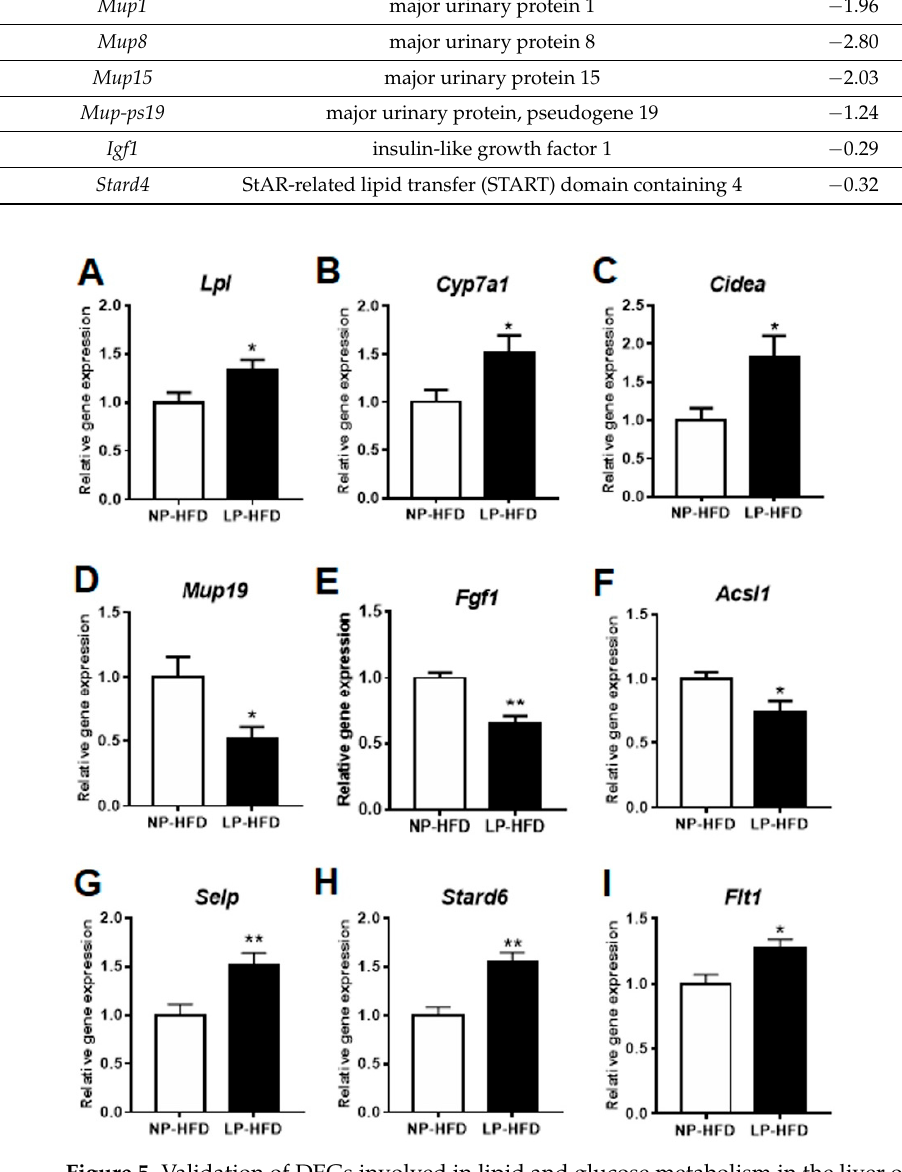
Figure 5. Validation of DEGs involved in lipid and glucose metabolism in the liver of NP-HFD and LP-HFD offspring. RT-qPCR was used to validate the RNA-seq data. The relative expression of Lpl ( A ), Cyp7a1 ( B ), Cidea ( C ), Mup19 ( D ), Fgf1 ( E ), Acsl1 ( F ), Selp ( G ), Stard6 ( H ), and Flt1 ( I ). n = 7–9 for each group. Data were expressed as mean ± SE. * p < 0.05; ** p < 0.01 LP-HFD vs.